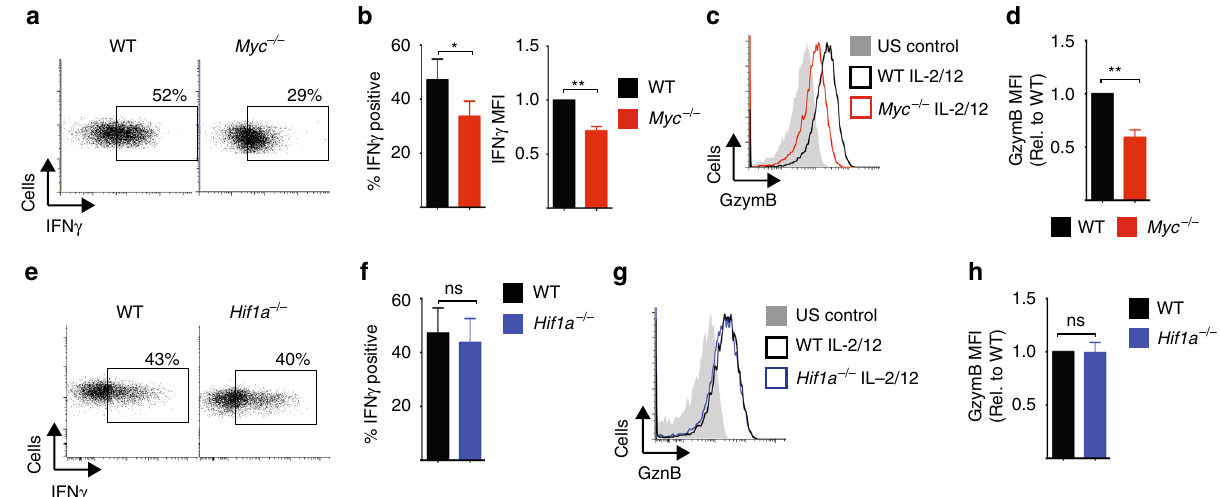
Fig. 2 cMyc, but not HIF1 α , is required for NK cell effector functions. a – d cMyc − / − ( cMyc fl ox/ fl ox × Tamox-Cre) or WT ( cMyc WT/WT × Tamox-Cre) NK cells were left unstimulated (US) or were stimulated for 18 h with IL-2/IL-12 before fl ow cytometry analysis for % IFN γ -positive NK cells and mean fl uorescence intensity (MFI) of IFN γ expression in IFN γ + NK cells, and granzyme B expression. e – h Hif1 α − / − ( Hif1 α fl ox/ fl ox × Vav-Cre) or WT ( Hif1 α fl ox/ fl ox ) NK cells were left unstimulated or were stimulated for 18 h with IL-2/IL-12 before fl ow cytometry analysis for percent IFN γ -positive NK cells and granzyme B expression. Data are mean ± s.e.m. or representative of fi ve independent experiments. Statistical analysis was performed using Student's t -test ( b , f ) or a one-sample t - test vs. a theoretical value of 1 ( b – h ); * p < 0.05, ** p < 0.01, ns non-signi fi